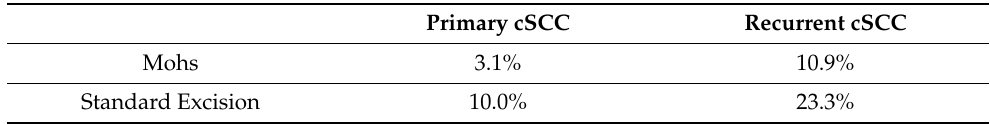
Table 3. Recurrence of localized cutaneous squamous cell carcinoma after surgery; cSCC, cutaneous squamous cell